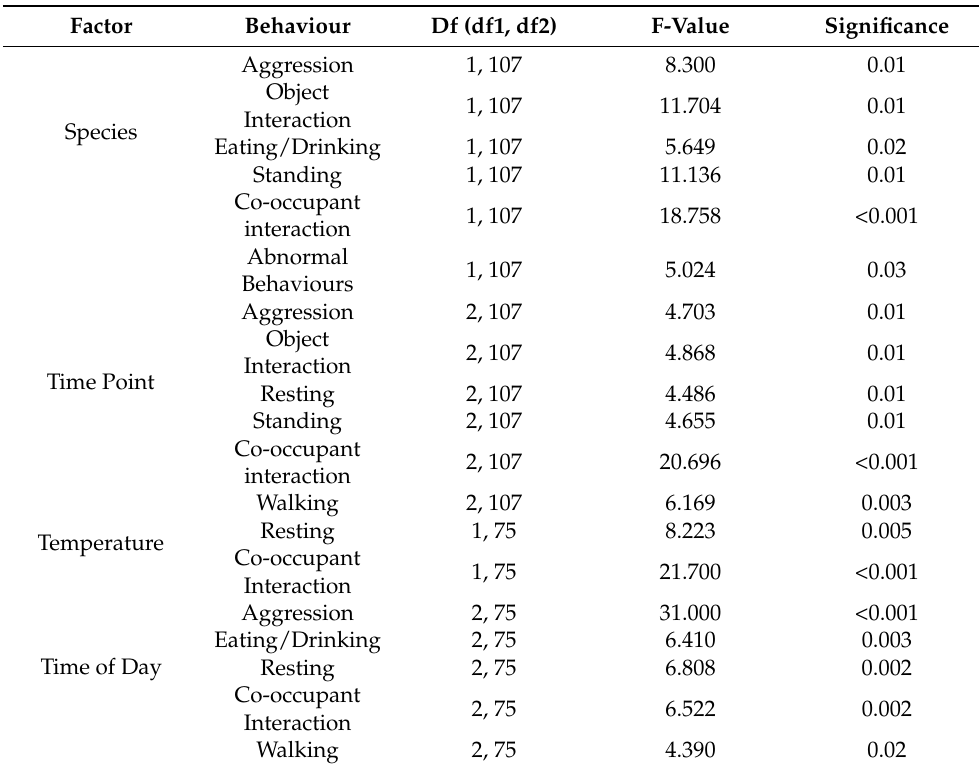
Table 2. GLM significant main